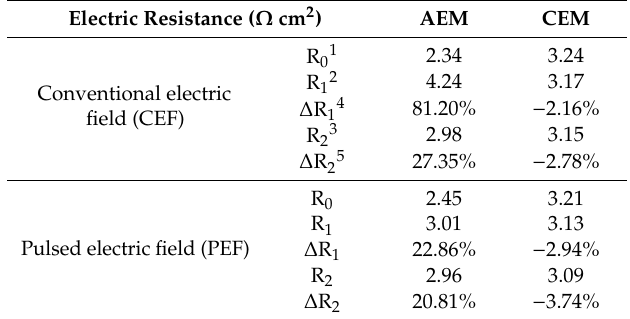
Table 3. Electric resistance of AEMs and CEMs before and after fouling under di ff erent electric field